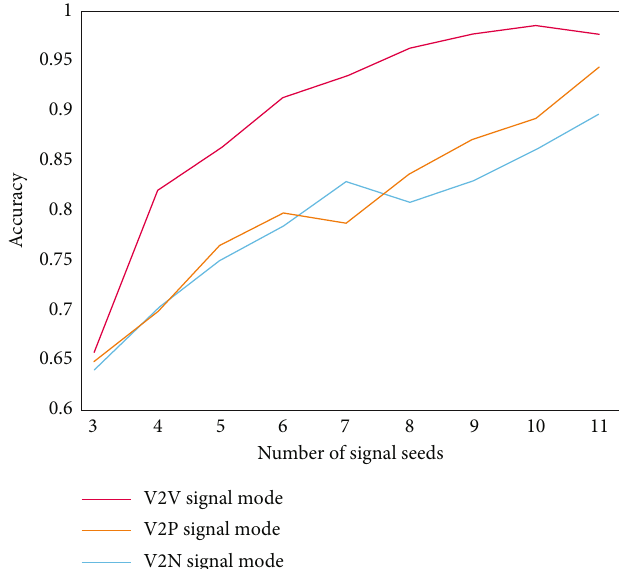
Figure 5: A line graph of the accuracy of the mathematical model in three signal modes as a function of the number of